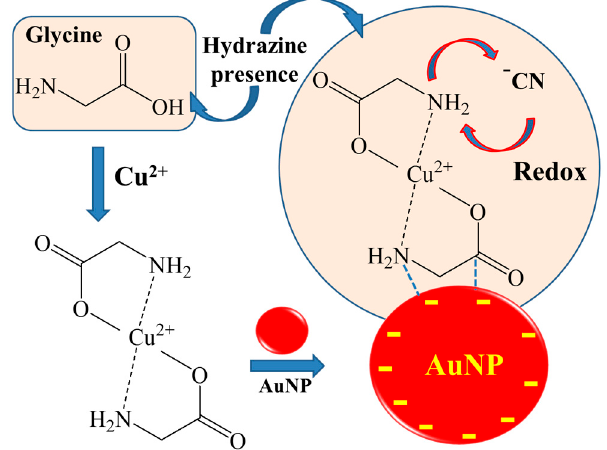
Figure 1. Schematic diagram of detection of Cu 2+ ions due to the redox properties to lead the dissociation of GLY into the CN group on AuNP surfaces in the presence of hydrazine. The GLY-Cu 2+ complex based on reference [19]. The increase of [Cu 2+ ] results in more positive redox properties of the GLY-Cu 2+ complex and stronger CN intensities.